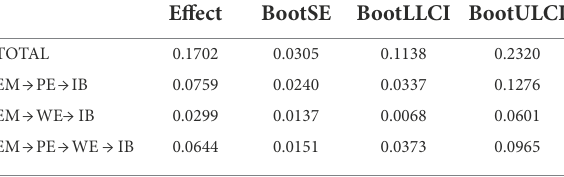
TABLE 5 Indirect effects of research